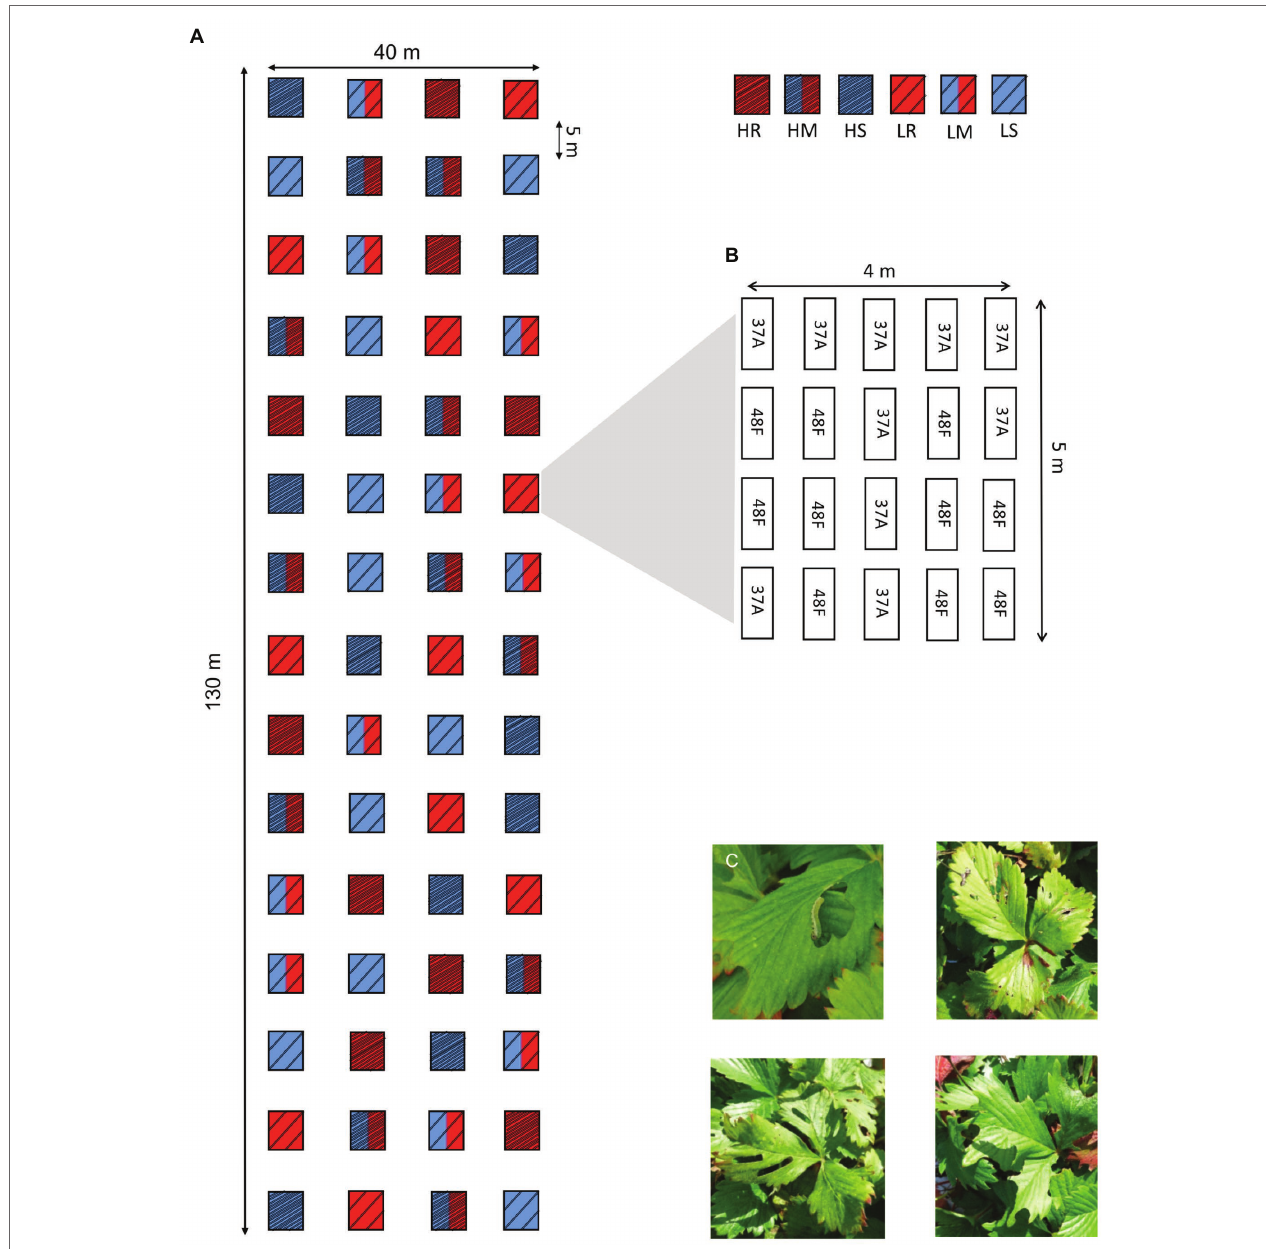
FIGURE 1 | (A) Schematic representation of the experimental design testing the effects of plot diversity (i.e., cultivar mixture) and resistance on chewing herbivore damage in woodland strawberry ( Fragaria vesca ). H= high diversity i.e, 10 varieties (dense stripes), L= low diversity, i.e, 2 genotypes (sparse stripes). Letters and color indicate different treatments: H = high diversity (dense stripes), L = low diversity (sparse stripes), R = resistant varieties (red), S = susceptible varieties (blue), and M = 50:50 mixture of resistant and susceptible varieties (red and blue). (B) Example of random arrangement of the varieties used in one of the plots [with low diversity resistant plots (LR)]. (C) Examples of herbivore damage observed in the plots. The majority of damage was caused by sawfly (Symphyta) larvae (top left). Photos by Sanne de